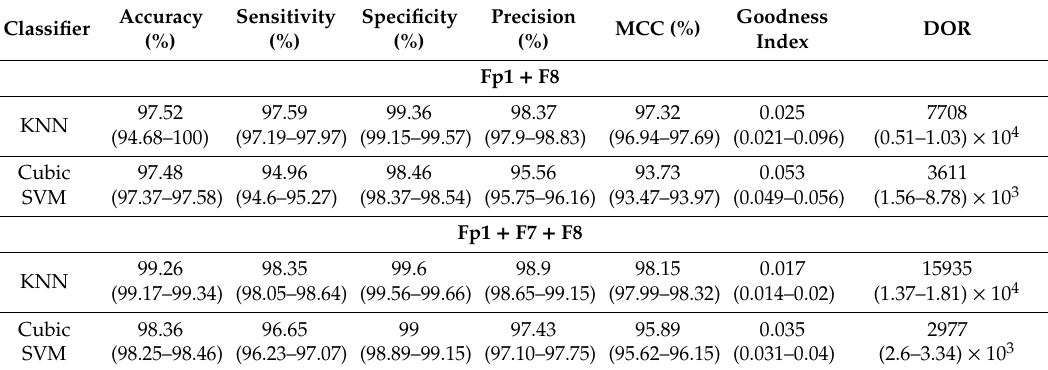
Table 10. Performance metrics (95% CI) of the proposed system constructed using (Fp1 + F7) and (Fp1 + F7 + F8) to evaluate stress levels using five-folds cross